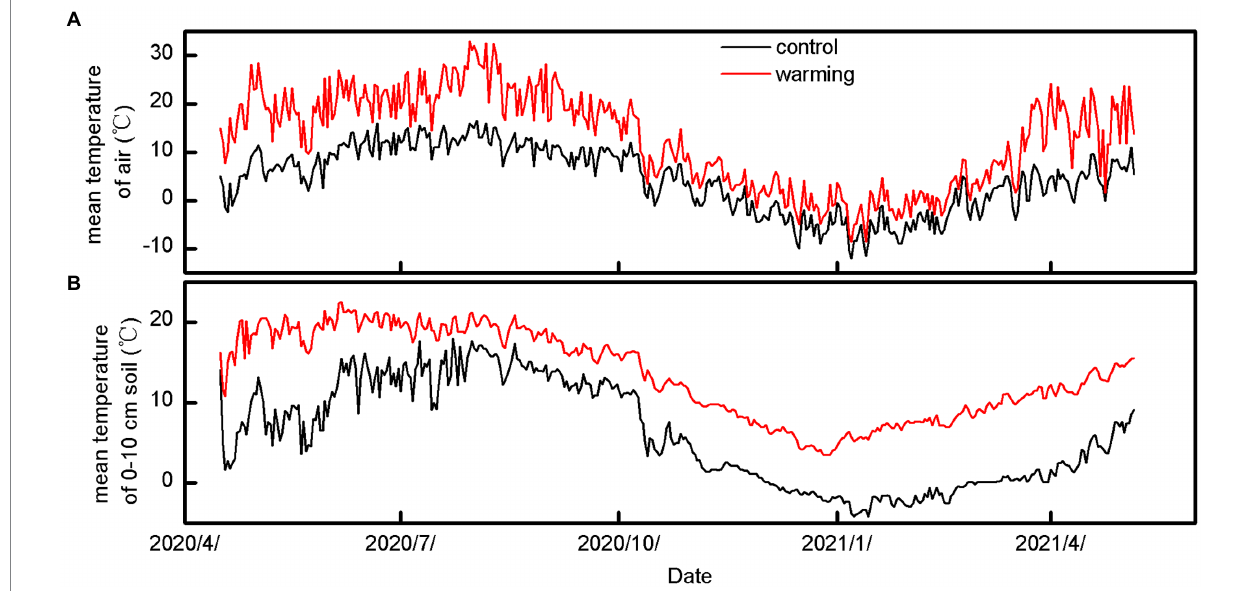
FIGURE 1 The mean temperature of air (A) and 10 cm soil (B) under control and warming during 20/4/2020–10/5/2021.